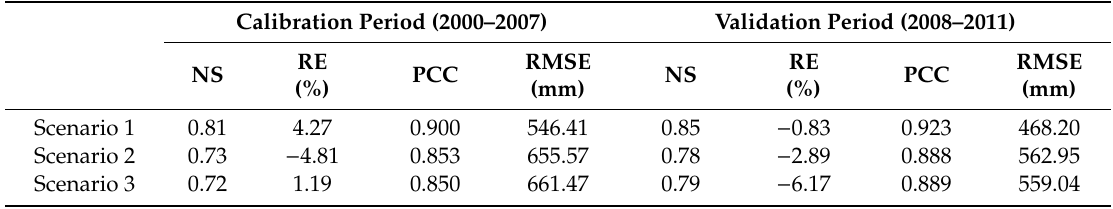
Table 4. Results of the four evaluation indices for the runo ff simulations under three